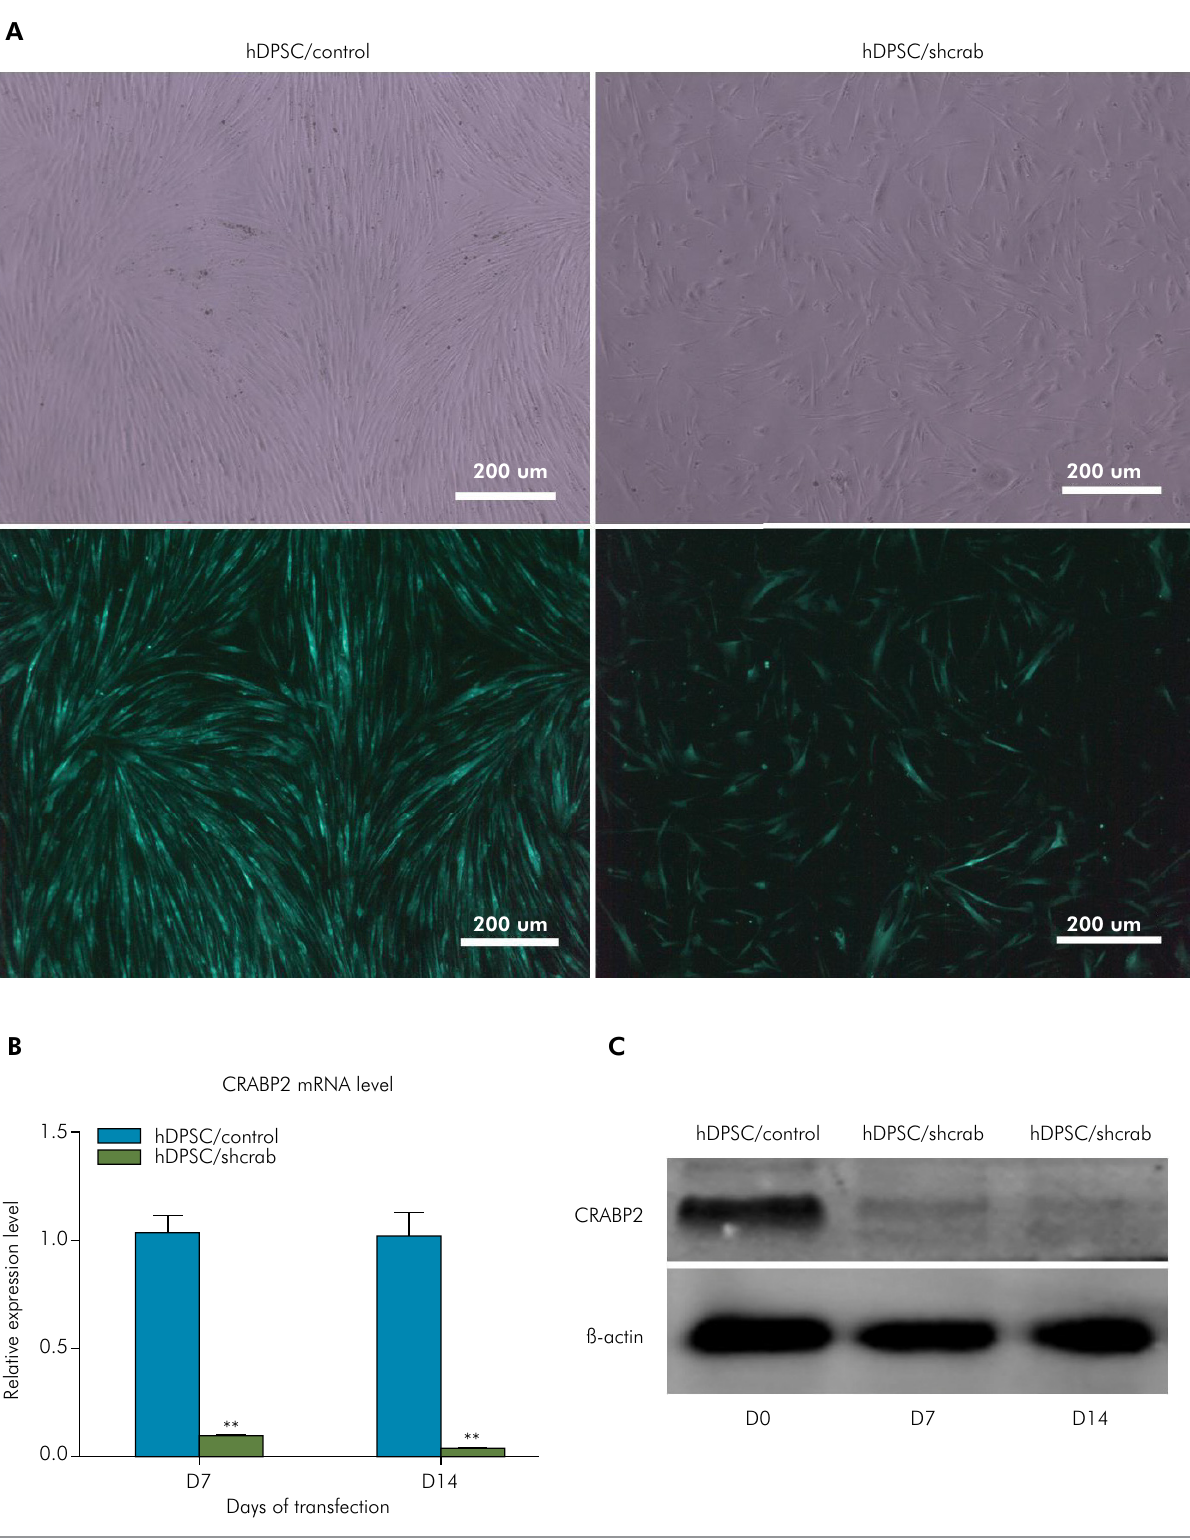
Figure 3. Stable knockdown of CRABP2 in hDPSCs. A: hDPSCs transfected with lentiviral vector in vitro exhibited GFP expression following transfection for 1 week and selection (x200). B and C: mRNA and protein levels of CRABP2 following hDPSC transfection with lentiviral vector in vitro for 7 and 14 days,